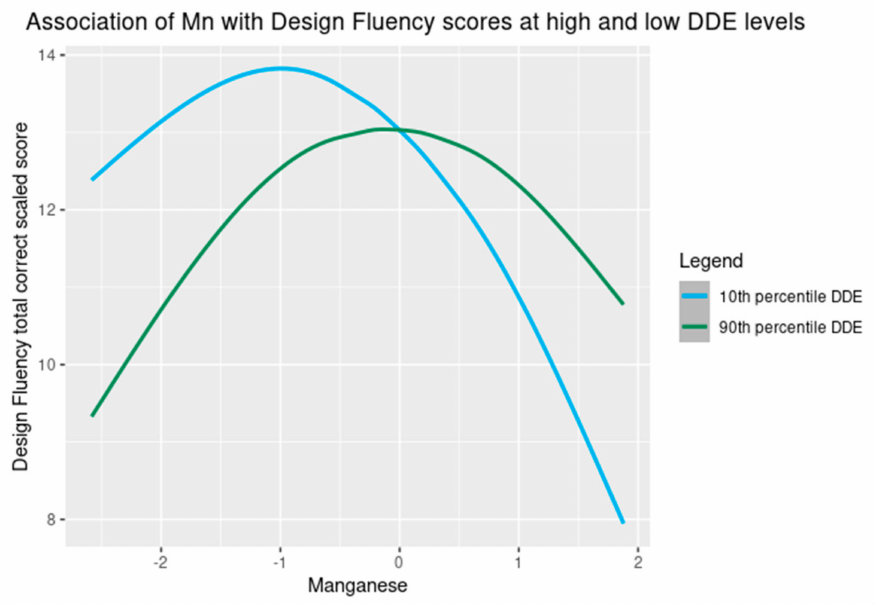
Figure 5. The association of prenatal Mn exposure with Design Fluency total correct scaled scores 1 when DDE levels are at the 10th and 90th percentile among adolescents in the main analysis